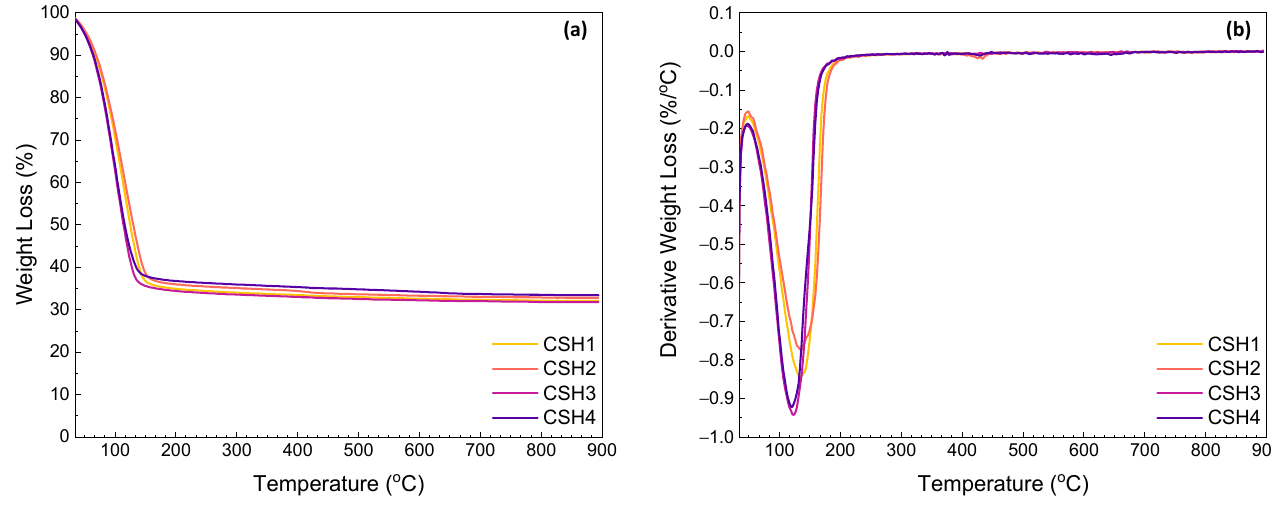
Figure 5. TGA ( a ) and DTG ( b ) curves for CSH gels at day 1.